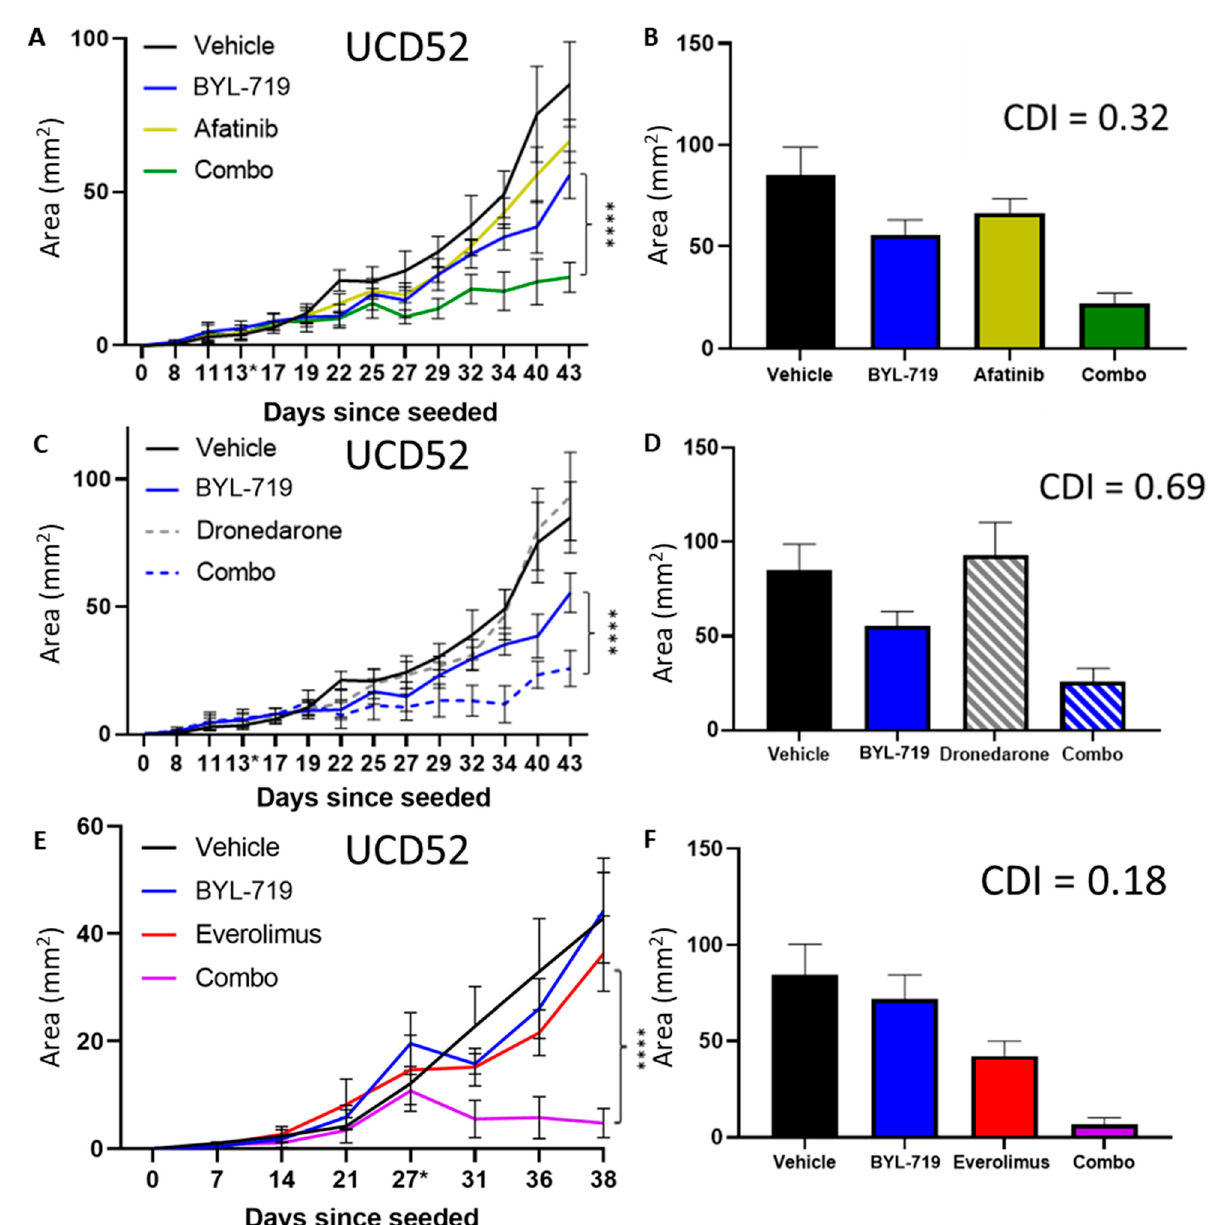
Figure 9. The combinations of everolimus, afatinib, or dronedarone with BYL-719 were significant and significantly synergistic in UCD52. BYL-719 tested in vivo in UCD52, comparing to alternative single agents, ( A , B ) afatinib, ( C , D ) dronedarone, and ( E , F ) everolimus and the combination of each with BYL-719. **** denotes p < 0.0001 significance, ANOVA after Tukey correction for multiple comparisons, comparing final tumor area. * on the days since seeded axis denotes the day that the treatment was started.